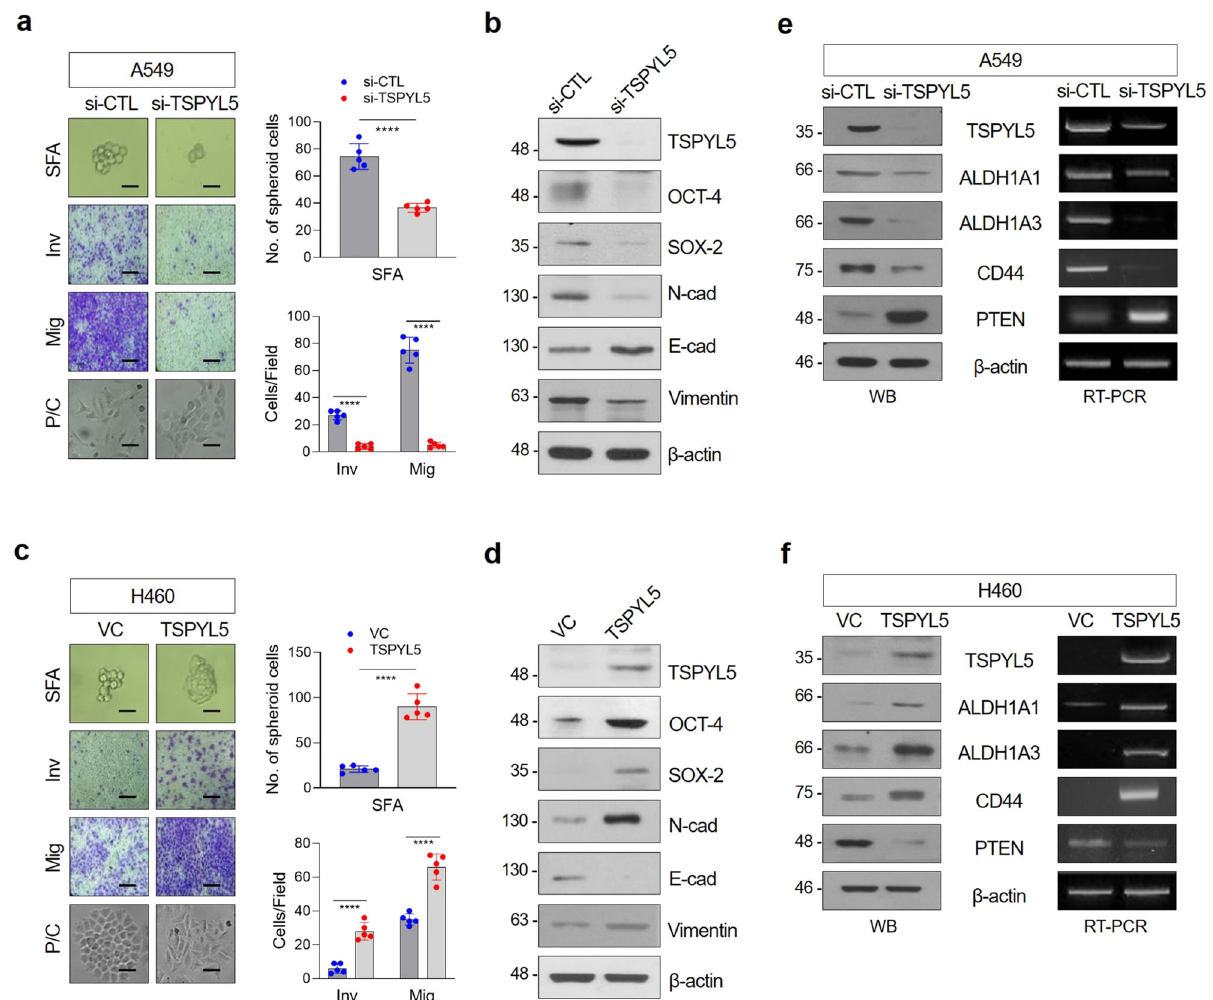
Fig. 3 TSPYL5 promotes the stemness and EMT of cancer cells through upregulation of ALDH1 and CD44 levels and downregulation of PTEN level. a, c Sphere formation, invasion/migration assay, and morphological observation indicated that the changes in stemness and EMT properties of cancer cells were affected by forced TSPYL5 suppression (si-TSPYL5) or overexpression (pcDNA3.1-TSPYL5) in A549 or H460 NSCLC cells. n = 5 independent experiments for each assay. Data represent mean ± s.d. using two-tailed t -test. **** p < 0.0001. Scale bar: 20 μ m. b , d Western blot analysis of CSC (OCT-4, SOX-2) and EMT (N-cadherin, E-cadherin, and Vimentin) biomarkers in cancer cells affected by forced suppression or overexpression of TSPYL5. e , f Western blot and RT-PCR analysis of ALDH1 (ALDH1A1, ALDH1A3 isoforms), CD44 (CD44s corresponding to transcript variant 4), and PTEN protein